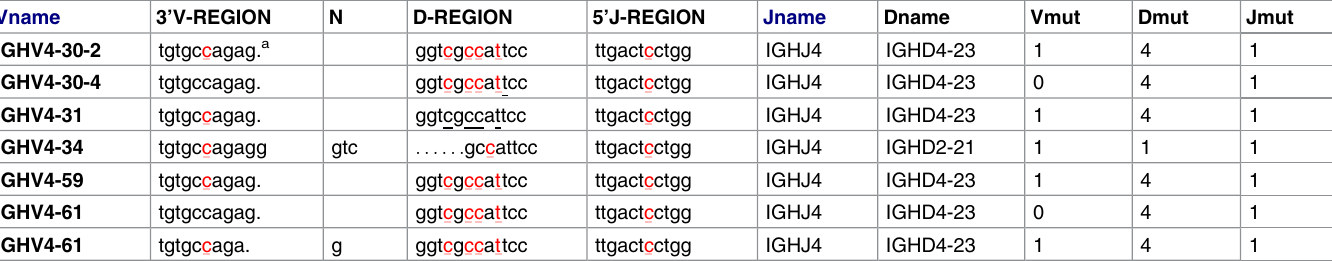
Table 6. The mutated position in LHG IgG heavy chain CDR3 sequences (CARGSPFLDSW).